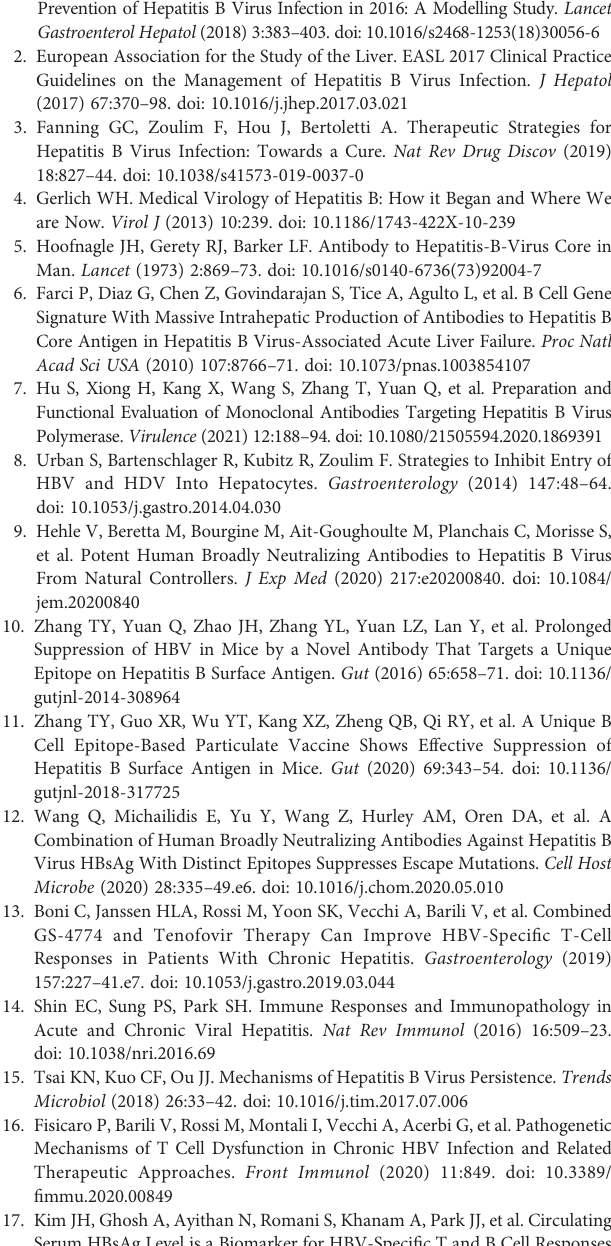
Supplementary Figure 3 | General recognition of linear B-cell epitopes on C and P proteins. (A) The recognition rate of the selected peptide on C and P proteins in patients with chronic HBV infection. (B) Positive peptide coverage on C and P. (C) Comparison of the number of positive epitopes on the C or P protein in patients with chronic HBV infection. (B) Chi-square test. (C) Mann – Whitney U test. * P < 0.05. Supplementary Figure 4 | The proportion of patients with different treatment responses in the S1+/- or S9+/- groups. Chi-square test. * P <